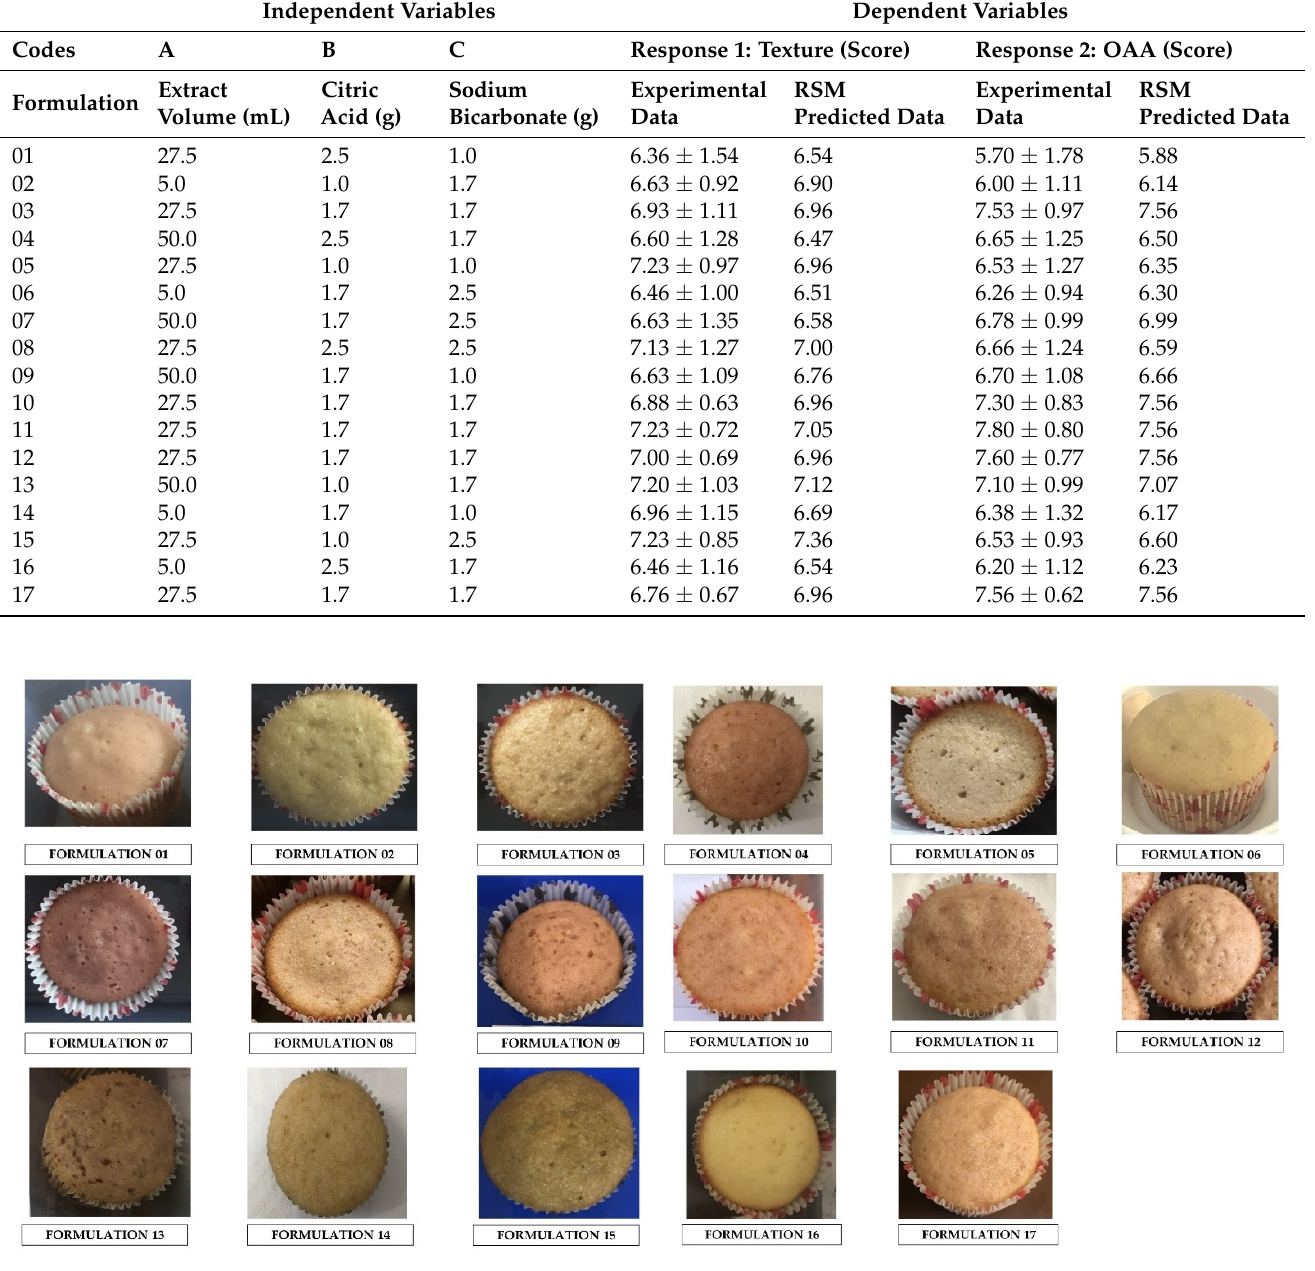
Table 1. Processed data on the muffin score given by the respondents.